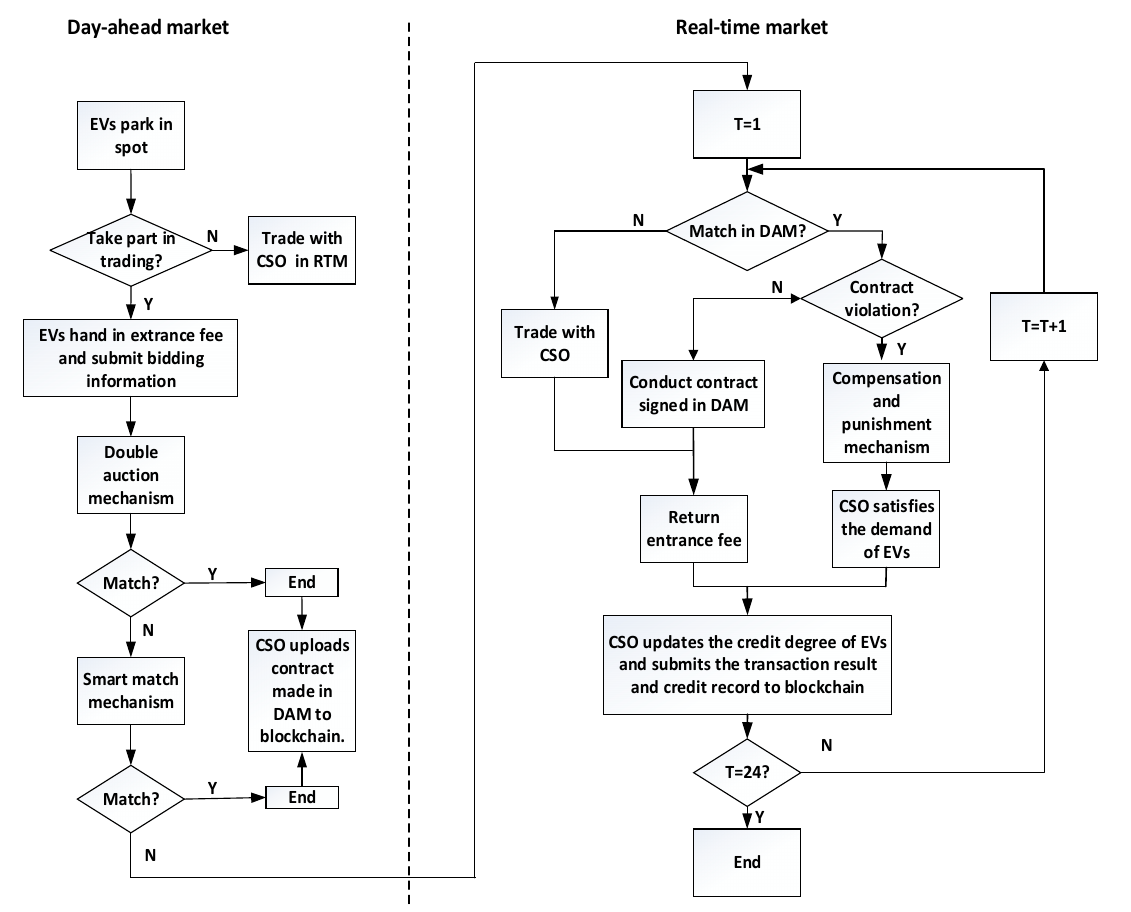
Figure 1. Framework of the proposed model.